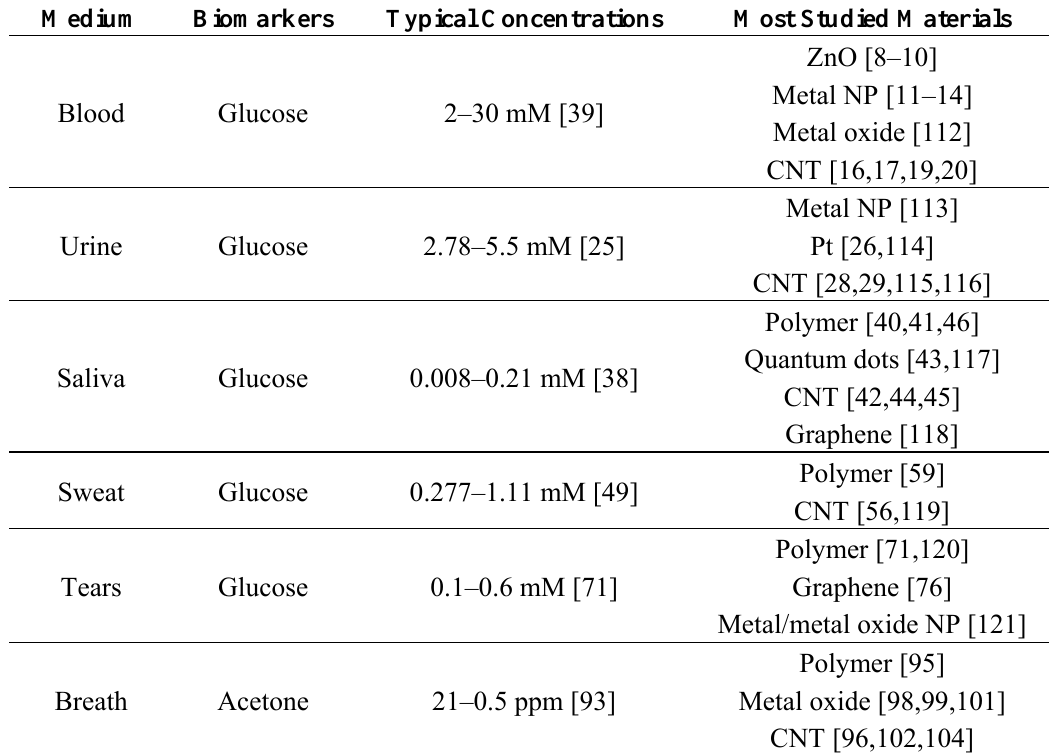
Table 1. A list of the most studied nano-materials for detecting typical biomarkers and the relevant concentrations in various mediums. CNT, carbon nanotube; NP,